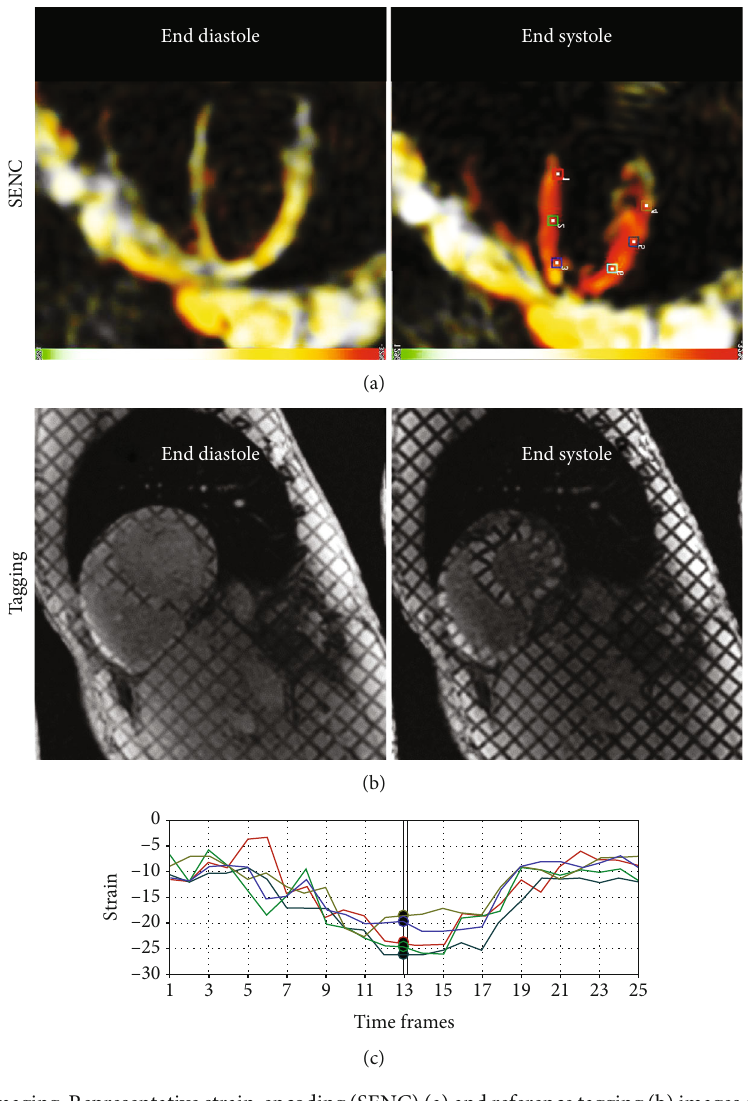
Figure 7: Strain-encoding imaging. Representative strain-encoding (SENC) (a) and reference tagging (b) images acquired at both end diastole and end systole in the same subject. Note: increased strain resolution (at the pixel level) and intuitive color-coded strain maps in SENC imaging compared to conventional tagging. (c) Circumferential strain curves generated from the SENC images at di ff erent positions shown by the markers in (a).